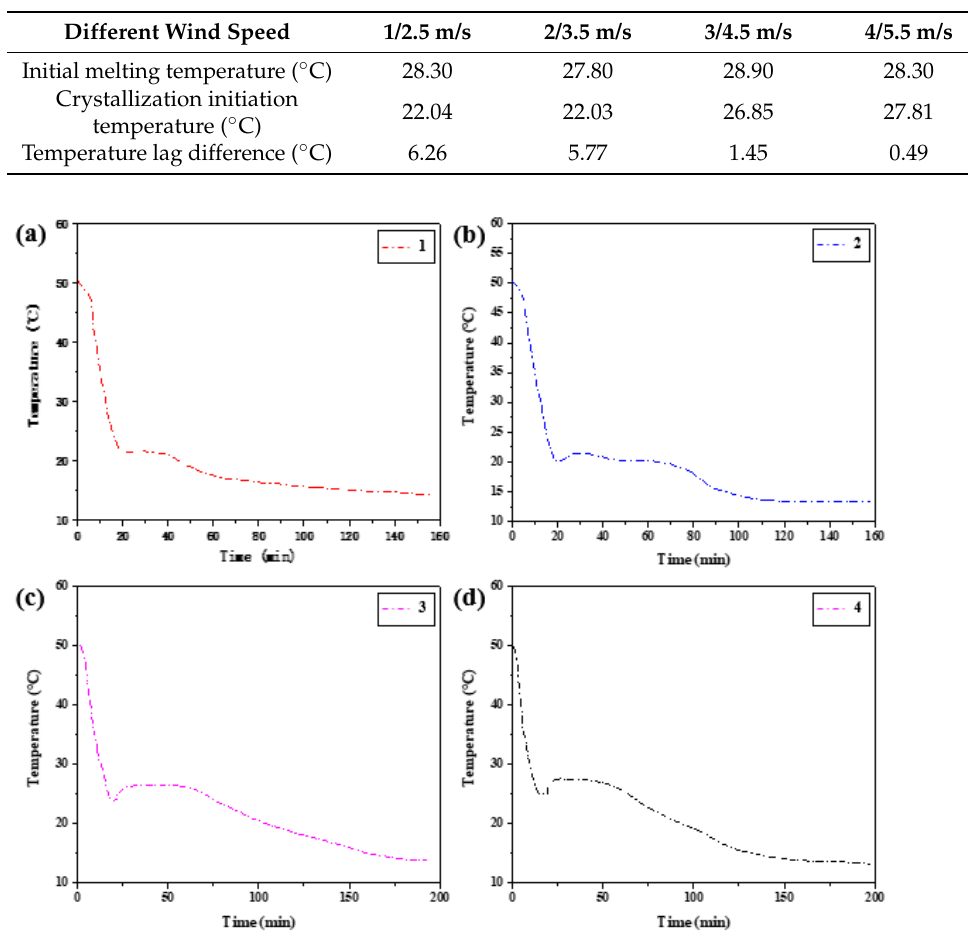
Figure 14. Step cooling curves of exothermic process at different cooling rates. Table 5. Melt initiation temperature and crystallization initiation temperature measured under dif- ferent wind speed conditions.